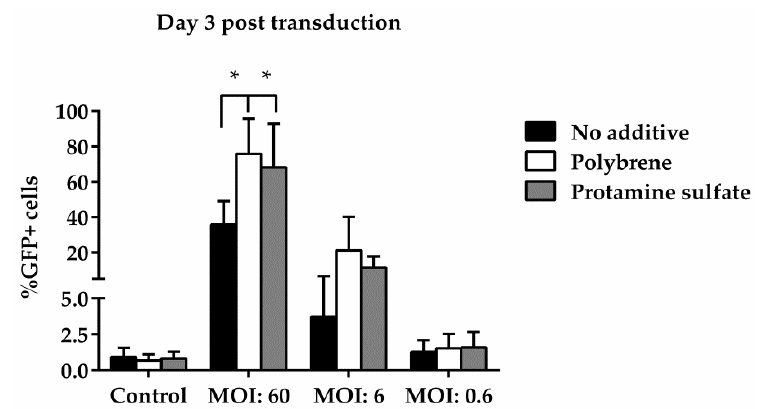
Figure 5. Comparative analysis of GFP expression in ovine macrophages, by flow cytometry, at various multiplicities of infection on Day 3 post transduction. Each MOI condition was repeated five times. Mock-transduced cells served as a negative control. GFP: green fluorescence protein; MOI: multiplicity of infection.